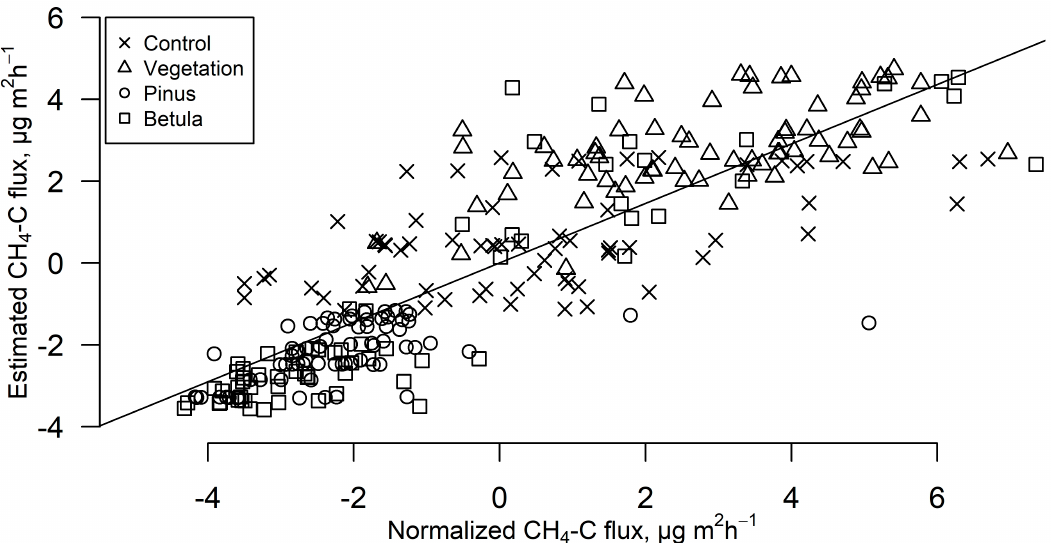
Figure 4. The linear mixed-effect model’s estimated and normalized (actual) CH 4 -C flux. Table 6. The linear mixed-effect model CH 4 -C flux variable significance (model coefficients pre- sented in Table S2).